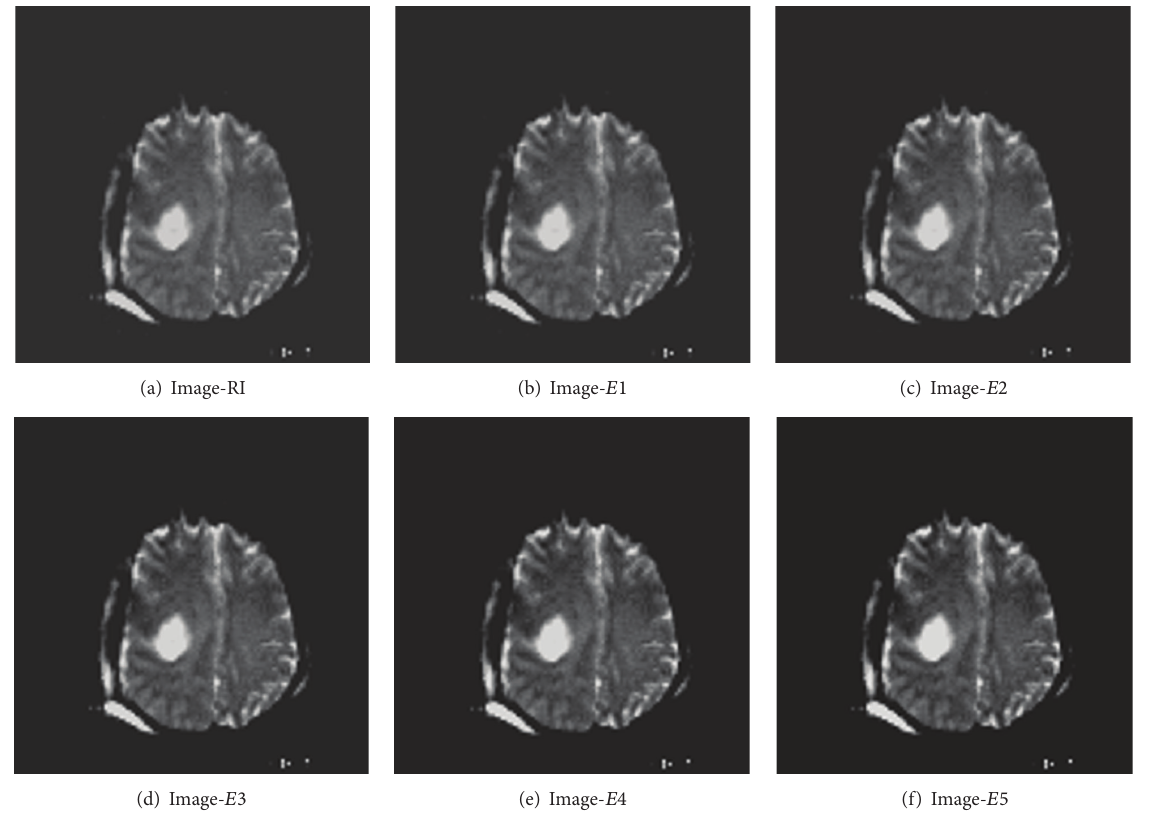
Figure 2: Different versions of one brain cancer